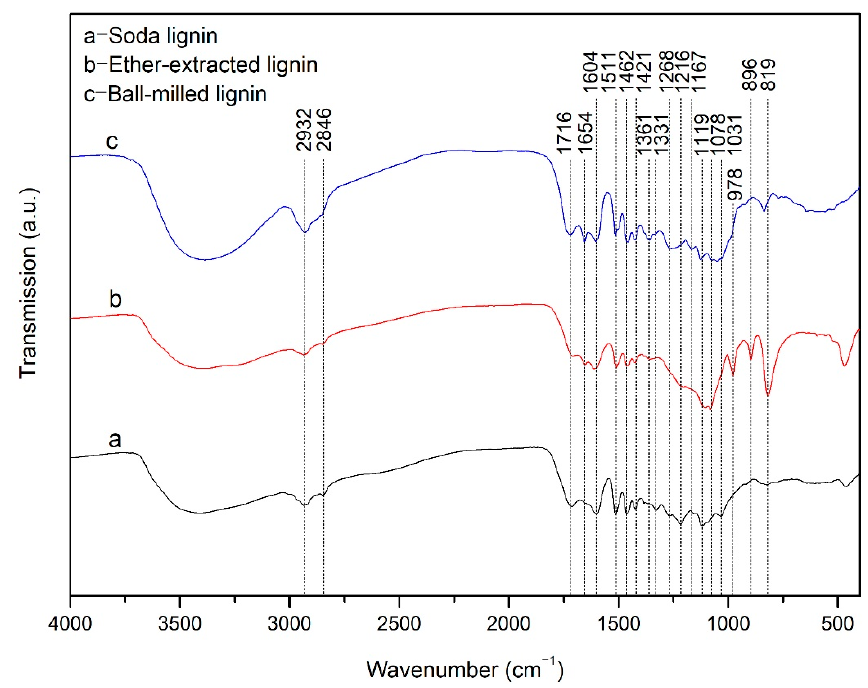
Figure 2. FT-IR spectra of ether-extracted lignin, ball-milled lignin, and soda